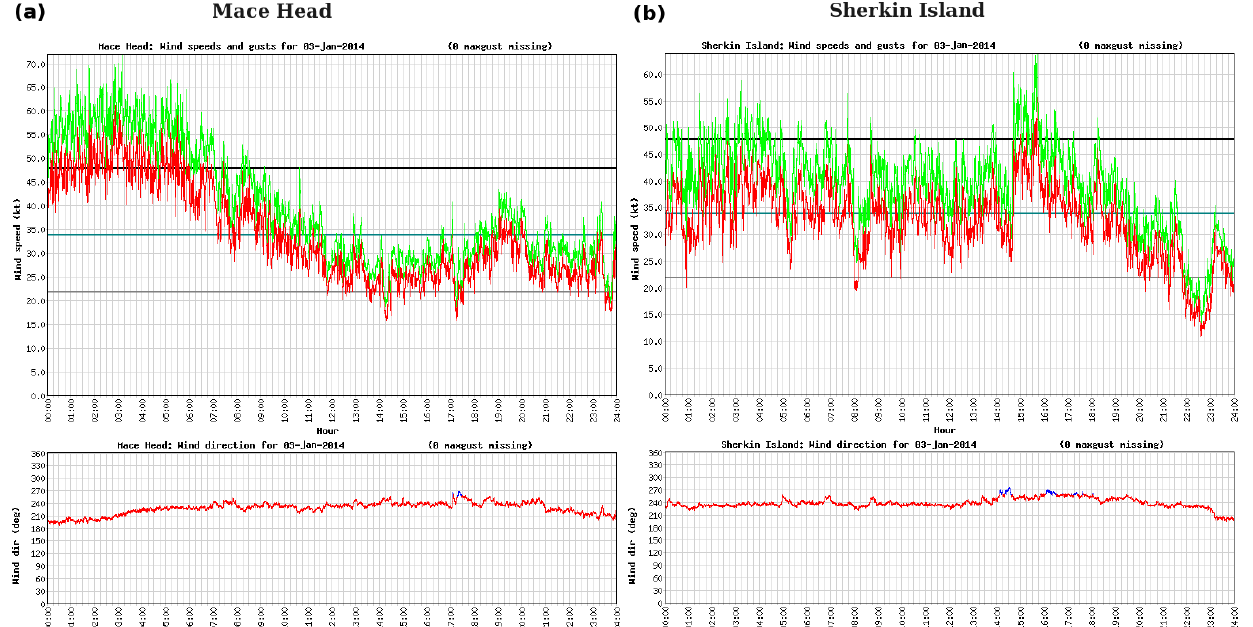
Figure 9. Observations from Met Éireann Synoptic (TUCSON) stations at (a) Mace Head and (b) Sherkin Island for wind speeds and gusts (top panels) and direction (bottom panels) on 3 January 2014. Top panels: Red = wind speed (kt); Green = wind gust (kt). For context, horizontal lines show mean speed boundaries on the Beaufort scale. Grey = Force 6 “Strong breeze” (22kt); Turquoise = Force 8 “Gale” (34kt); and Black = Force 10 “Storm” (48kt). Note the different scales for wind speed. Bottom panels: Direction of wind speeds and gusts ( ◦